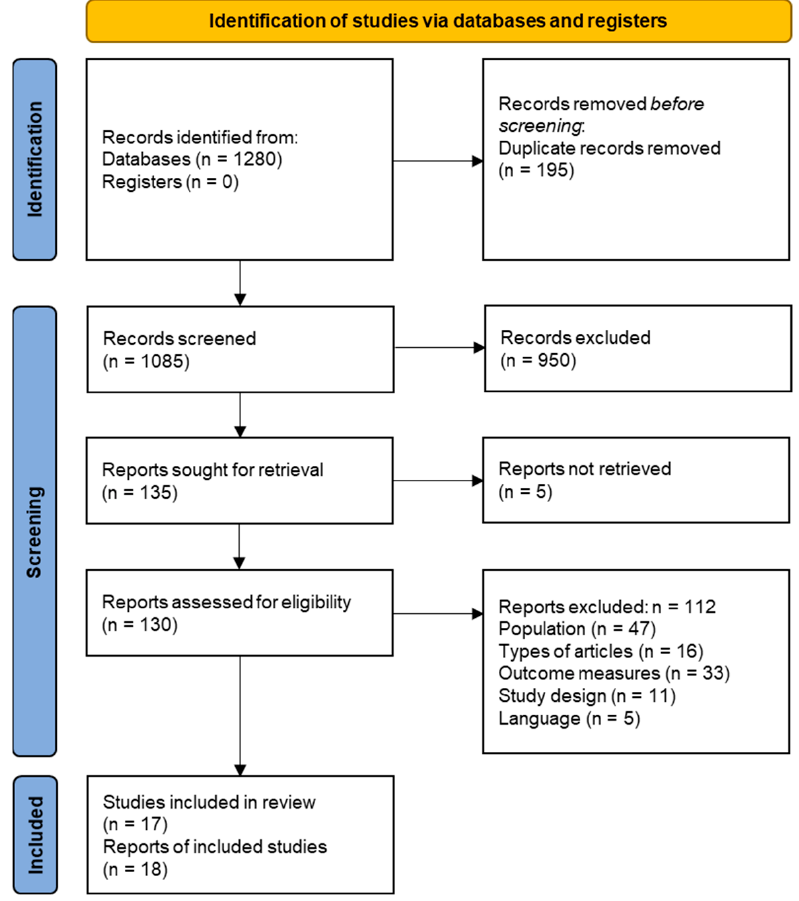
Figure 1. PRISMA flow chart showing the selection process of included studies.